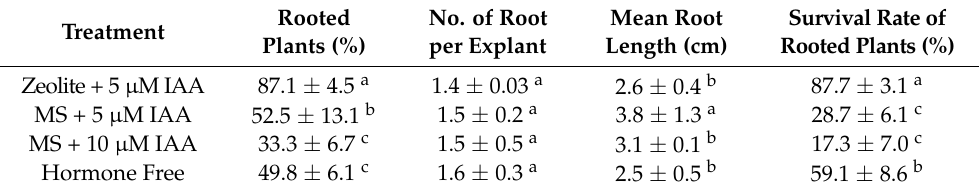
Table 2. Effect of different rooting treatments on root formation in C. maritima